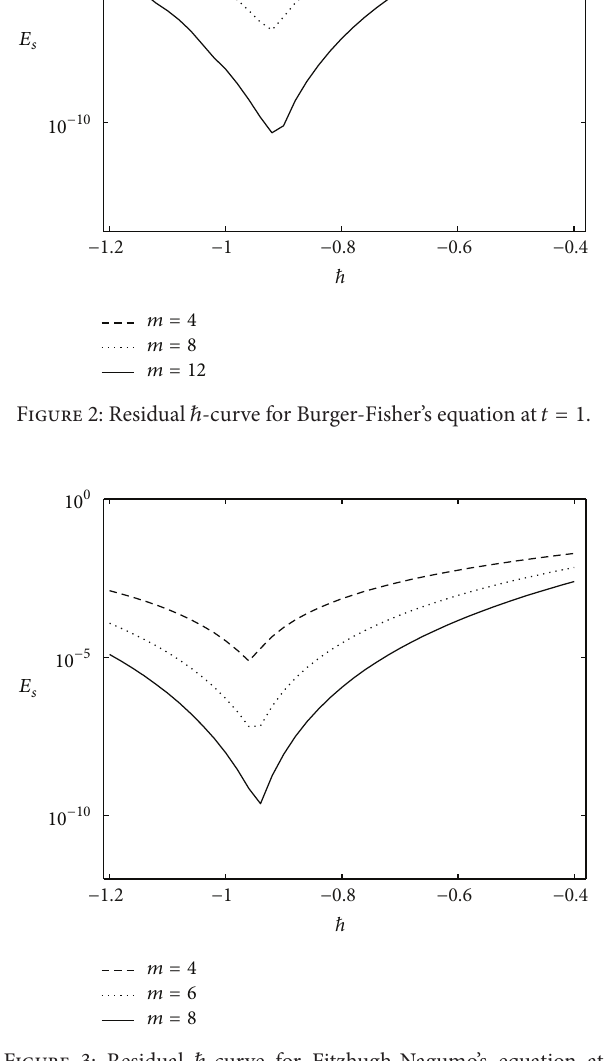
Figure 3: Residual ℎ -curve for Fitzhugh-Nagumo’s equation at 𝑡 = 1